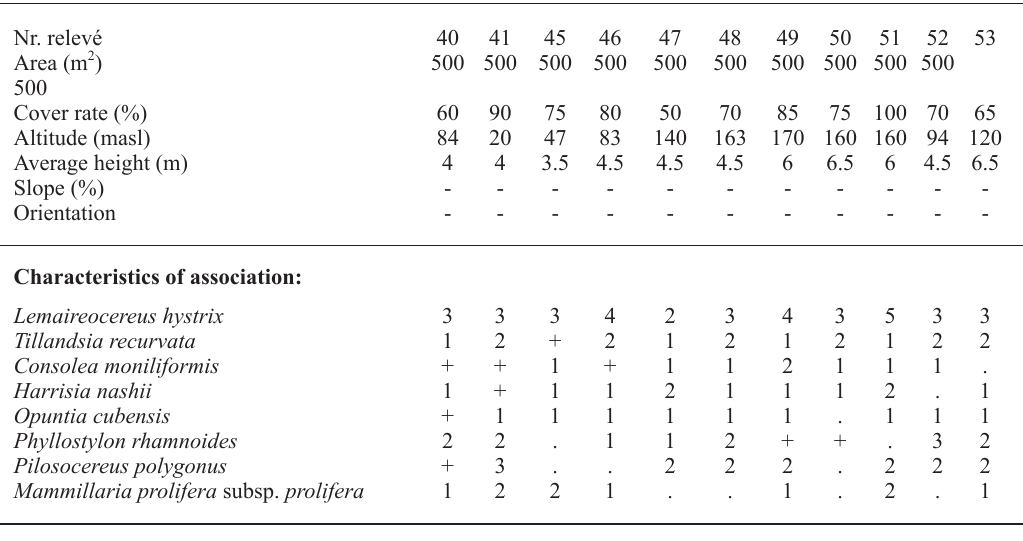
Lemaireocereo hystricis-Prosopidetum juliflorae ass.